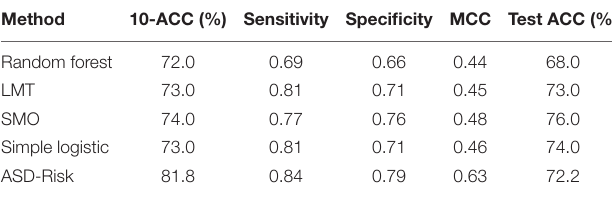
TABLE 1 | Performance comparison among ASD-Risk and some typical classifiers.